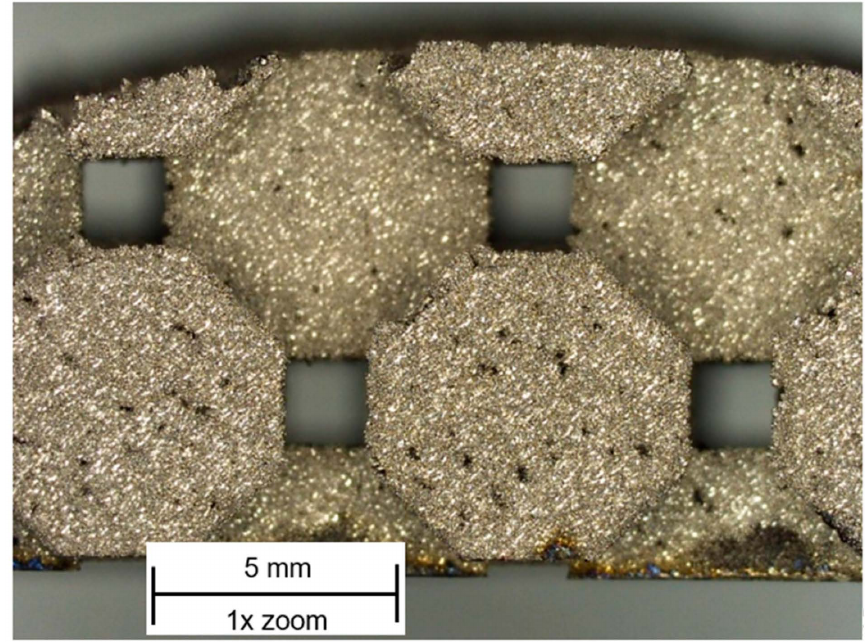
Figure 9. Top view of optical macroscope image of AUX lattice section, showing loss of material on horizontal